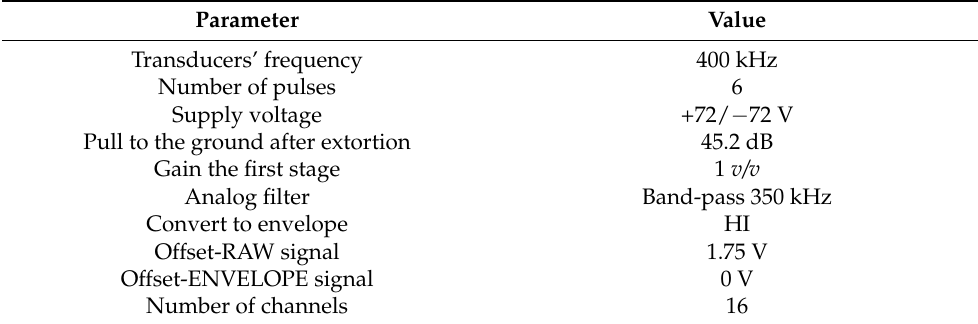
Figure 1. A tank reactor with the integrated USCT system. Table 1. The main design features, structural parameters, and values of the utilized ultrasound tomography